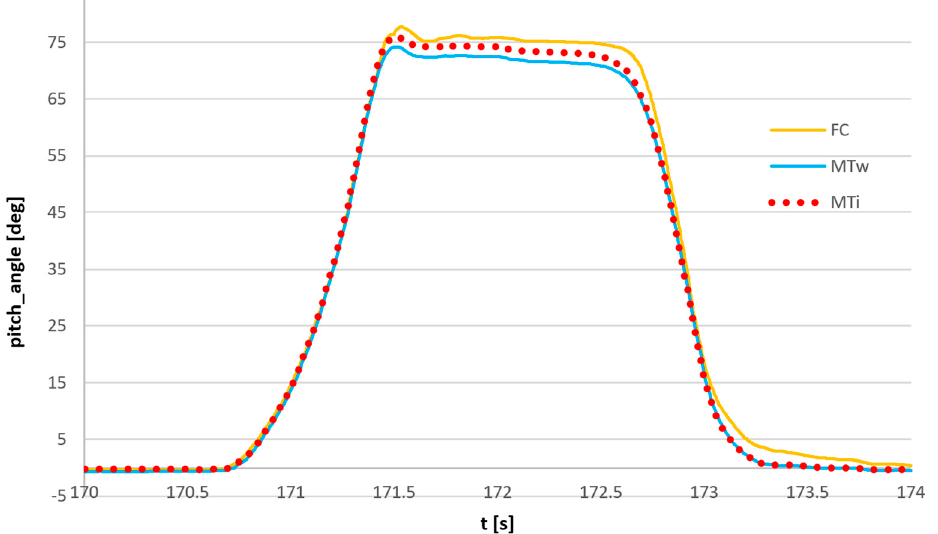
Figure 21. Synchronized measurement of the pitch angle, magnification of the single movement: MTi: reference signal, Xsens MTi-G700 sensor; MTw: Xsens Awinda wireless sensor; FC: flight controller sensor.